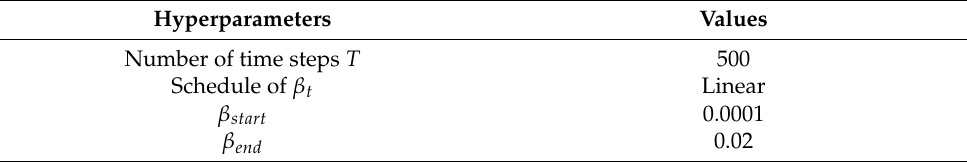
Table 2. Hyperparameters used in the forward